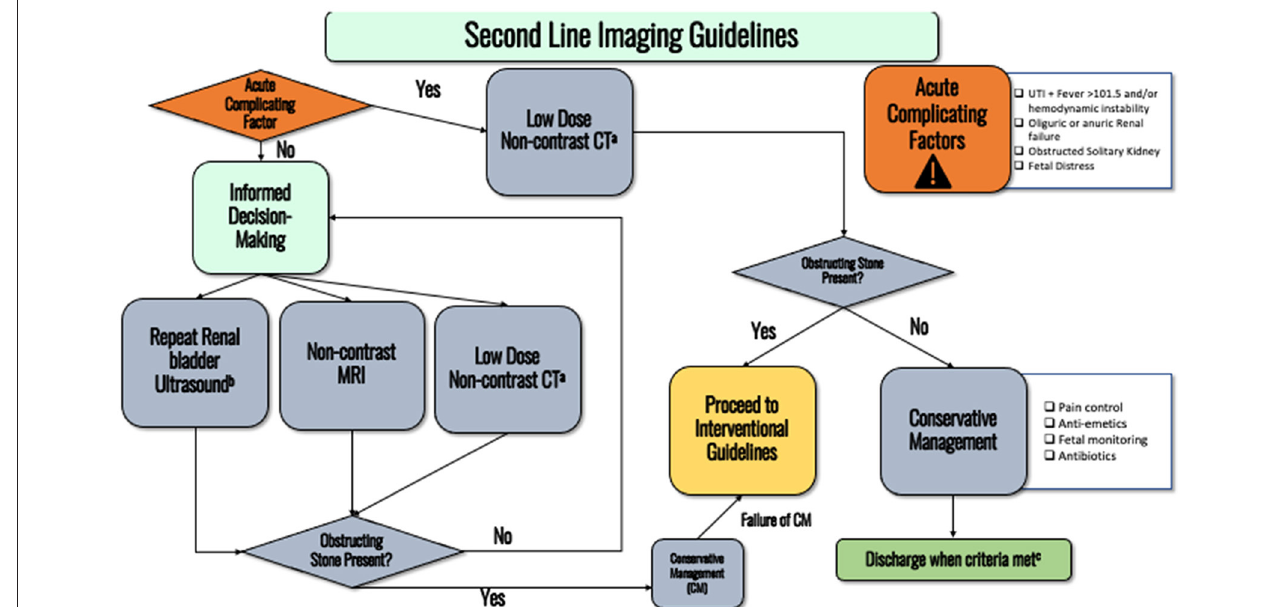
FIGURE 2 | Flowchart detailing the second-line imaging guidelines. (a) Consider discussing with medical physicist to ensure lowest possible radiation dose is administered. (b) Pain is adequately controlled on oral pain medications, nausea well controlled and able to eat/drink, no AKI and stable creatinine, afebrile, non-concerning fetal monitoring. (c) Transvaginal ultrasound can more accurately detect distal ureteral stones.